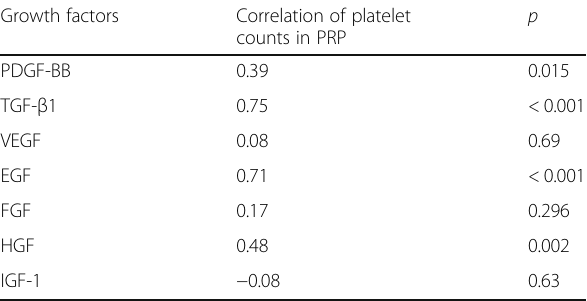
Table 4 Spearman ’ s correlation coefficients for platelet counts in platelet rich plasma and growth factor levels Growth factors Correlation of platelet counts in